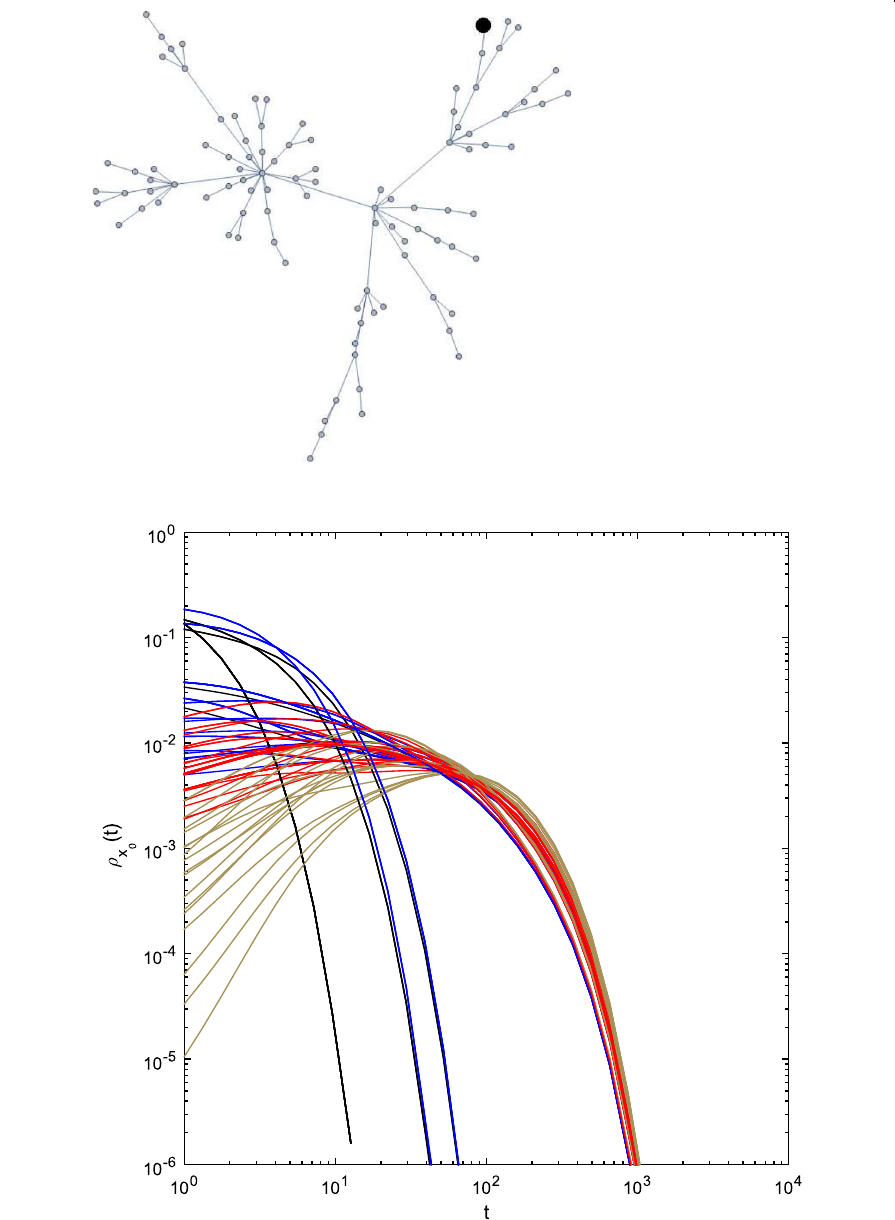
Fig. 5 (Top) Example of a SF network with the fixed absorbing node x a marked by black circle. (Bottom) FPT densities on SF network G(N; m; m 0 ) N=100, m=1, m 0 =6 for different starting points x 0 and a fixed absorbing node x a such that: ∣ x 0 − x a ∣ =1 (black), ∣ x 0 − x a ∣ =2 (blue), ∣ x 0 − x a ∣ =3 (red) (FPT densities with ∣ x − x ∣ >3 are shown in grey). The travel time distribution is ~ ψ a 0 fixed trap node at which α =